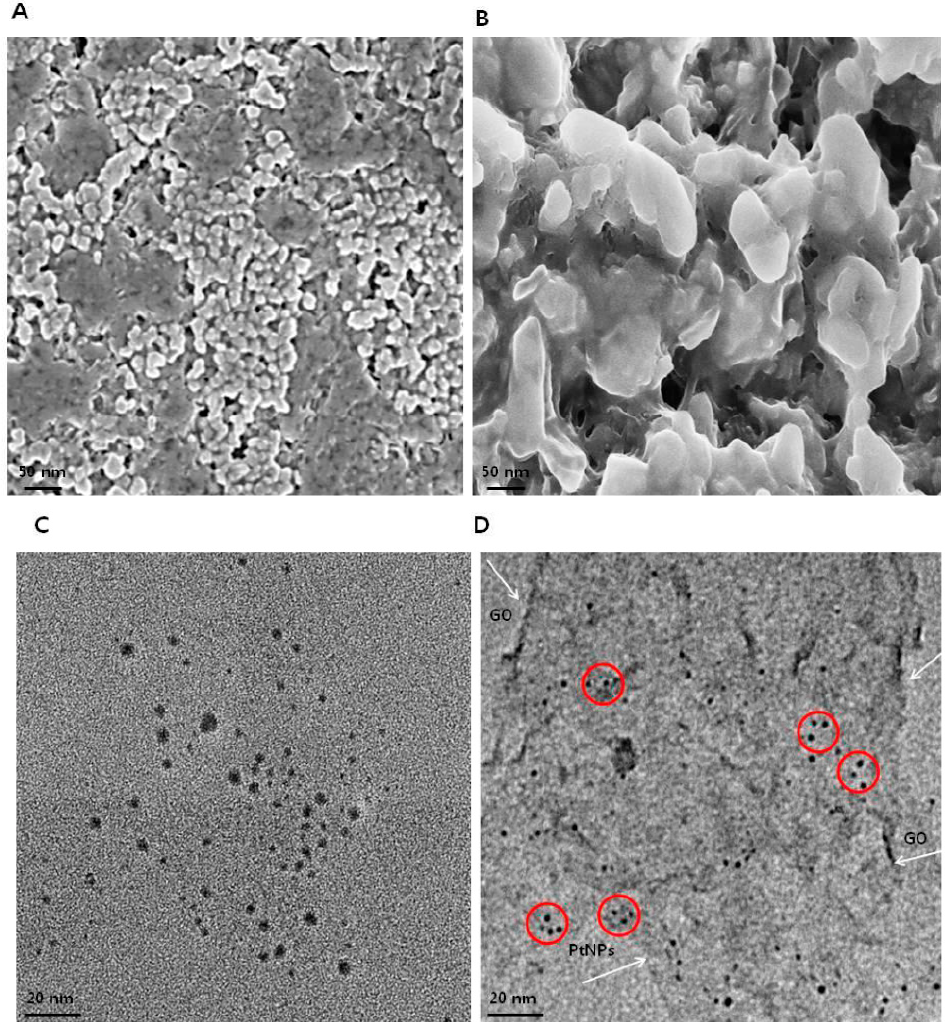
Figure 5. Characterization of GO and GO-PtNPs by SEM and TEM. Morphology of GO ( A ) and GO-PtNPs ( B ), and size of GO ( C ) and GO-PtNPs ( D ) were analyzed by SEM and TEM, respectively. The red circle indicates decoration of PtNPs particles on the surface of graphene sheet (White arrow). The graphene sheet depicted as wrinkled sheet-like structure.